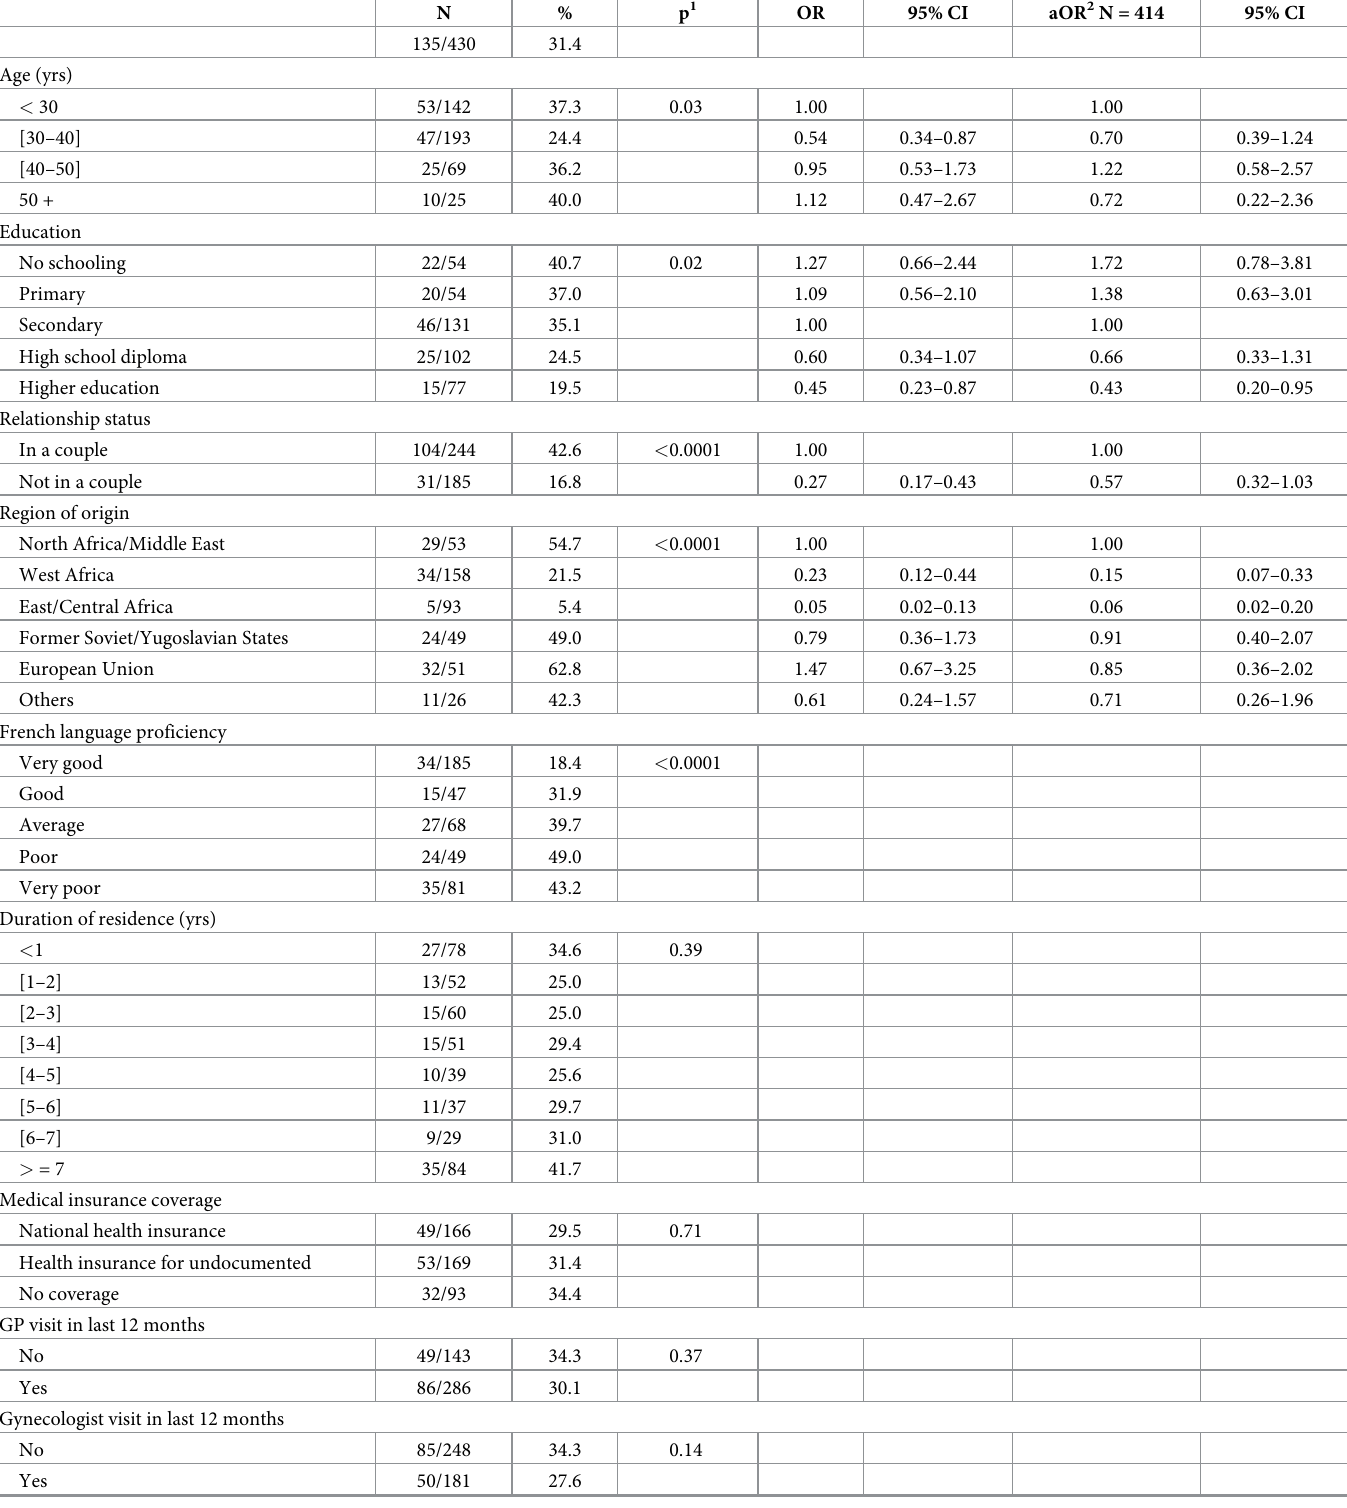
Table 3. Characteristics associated with no lifetime HIV test, bivariate and multivariate analyses, DSAFHIR